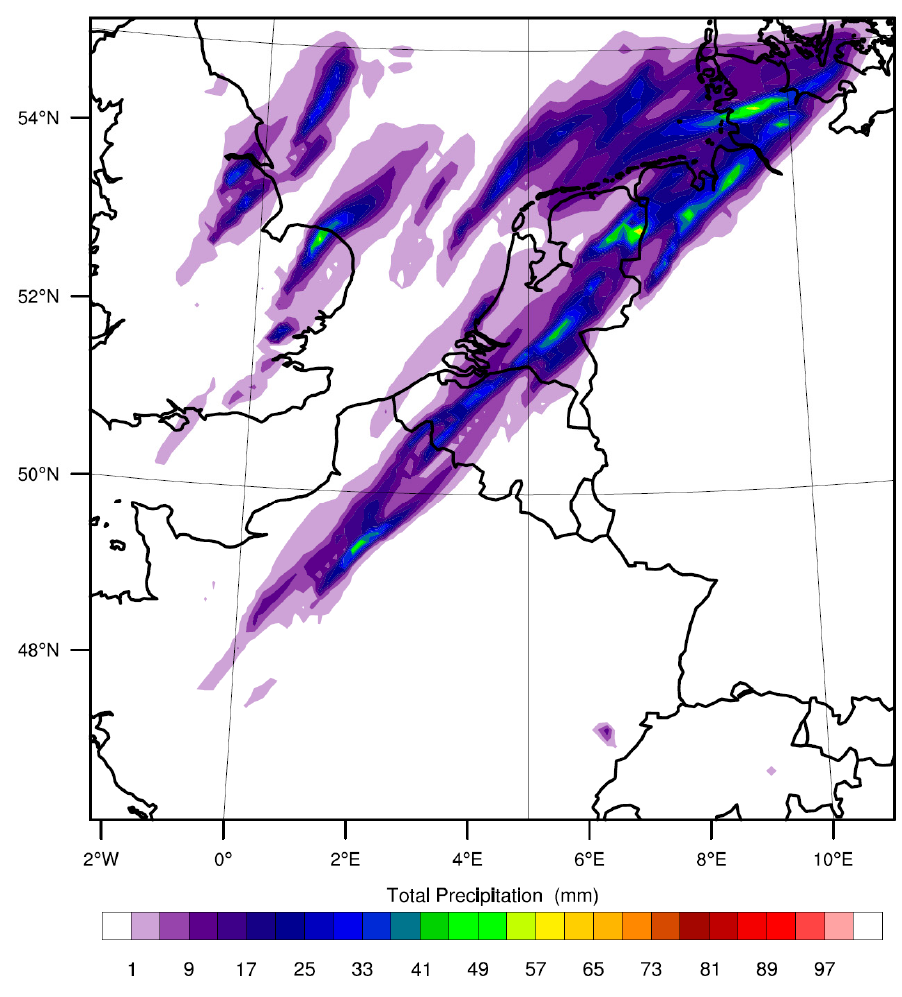
Figure 8. Modelled accumulated precipitation between 23 June 2016 14:00 UTC–24 June 2016 0:00 UTC at 10 km grid spacing without convection parameterisation.